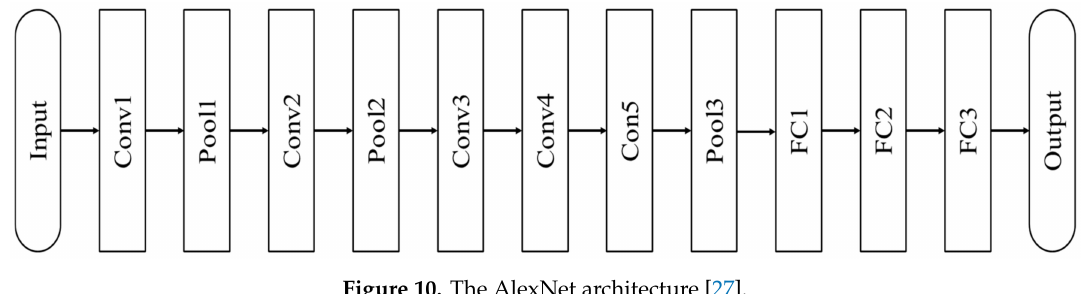
Figure 10. The AlexNet architecture